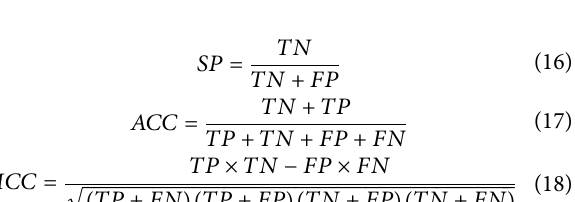
Frontiers in Pharmacology |